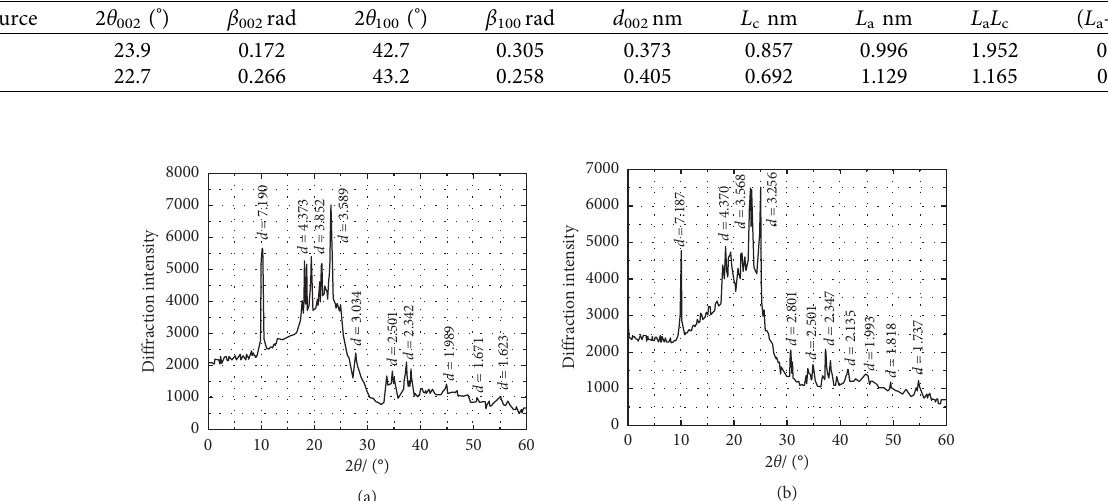
Table 3: Comparison of the XRD structural parameters of the coal samples.